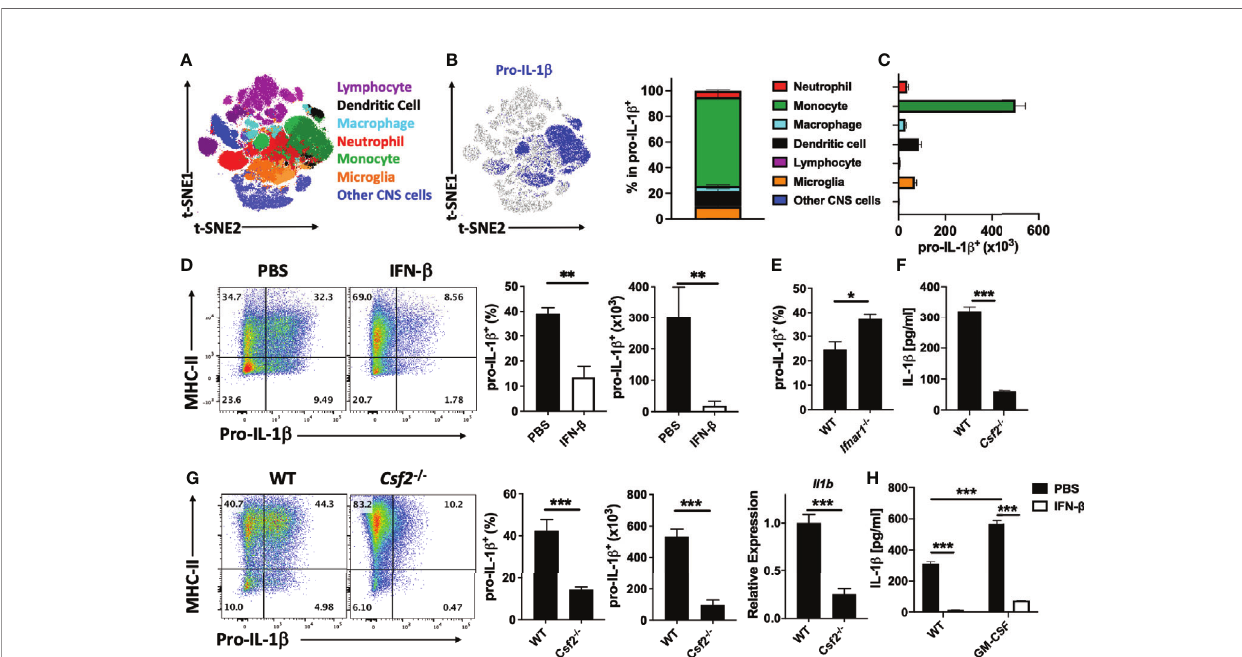
FIGURE 7 | rIFN- b suppresses pro-IL-1 b expression by the CNS monocytes. WT mice (n=5) were immunized for EAE induction, sacri fi ced at disease peak (day 15 p.i.), and mononuclear cells from the CNS analyzed by fl ow cytometry. (A) t -SNE plot showing seven populations of cells from CNS that were generated by PhenoGraph unbiased clustering. (B) Proportions (%) of CNS cell populations expressing pro-IL-1 b . (C) Total numbers of pro-IL-1 b -expressing cells from the CNS. (D) WT mice (n=4 per group) were immunized for EAE induction and treated daily with PBS or rIFN- b . Mice were sacri fi ced at disease peak (day 15 p.i.) and monocytes from the CNS analyzed by fl ow cytometry for pro-IL-1 b expression. Representative fl ow cytometry dot plots showing MHC-II and pro-IL-1 b expression by monocytes in the CNS of mice with EAE. Proportions (%) and total numbers of pro-IL-1 b + monocytes in the CNS of mice with EAE. (E) WT and Ifnar1 -/- mice (n=5 per group) were immunized for EAE induction, sacri fi ced at disease peak (day 15 p.i.), and monocytes from the CNS analyzed by fl ow cytometry for pro-IL-1 b expression. Proportions (%) of pro-IL-1 b + monocytes from the CNS of mice with EAE are shown. (F) Splenic WT and Csf2 -/- naïve CD4 + T cells were co-cultured with WT APCs, activated with anti-CD3/28 Abs, and GM-CSF concentrations in cell culture supernatants measured by ELISA after 72 h of culturing. (G) WT and Csf2 -/- mice (n=5 per group) were immunized for EAE induction, sacri fi ced at disease peak (day 15 p.i.), and CNS in fi ltrated monocytes analyzed by fl ow cytometry for pro-IL-1 b expression. Representative fl ow cytometry dot plots showing MHC-II and pro-IL-1 b expression. Proportions (%) and total number of pro-IL-1 b + monocytes. Il1b expression by mononuclear cells from CNS of mice with EAE was determined by RT-PCR. (H) Splenic naïve CD4 + T cells were co-cultured with APCs and activated with anti-CD3/28 Abs with or without addition of GM-CSF (20 ng/ml) and rIFN- b . GM-CSF concentrations in cell culture supernatants were measured by ELISA after 72 h of culturing. These experiments were conducted three times with similar outcomes. Data shown are mean ± SEM. P-values were calculated using unpaired Student ’ s t -test in (D – G) , and one-way ANOVA with Bonferroni ’ s multiple comparisons test in (H) ; *p < 0.05**p < 0.01, ***p <